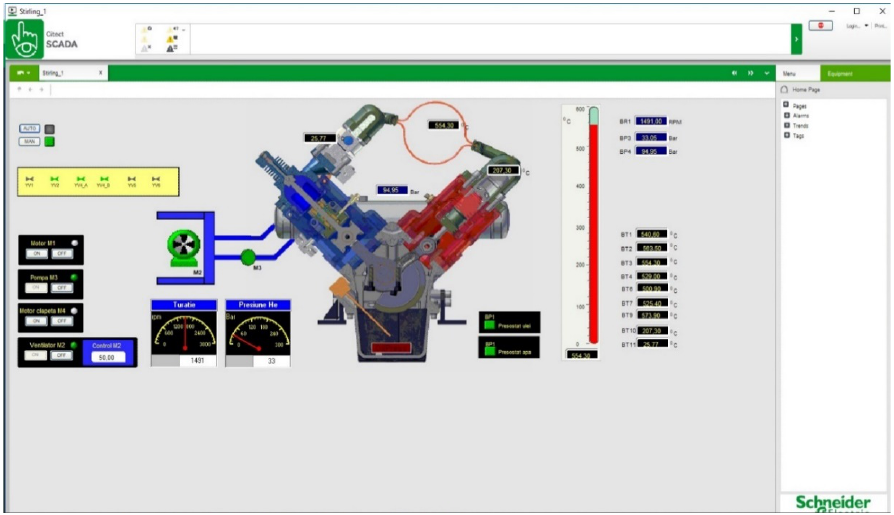
Figure 16. HMI control and monitoring interface. Process control screen.